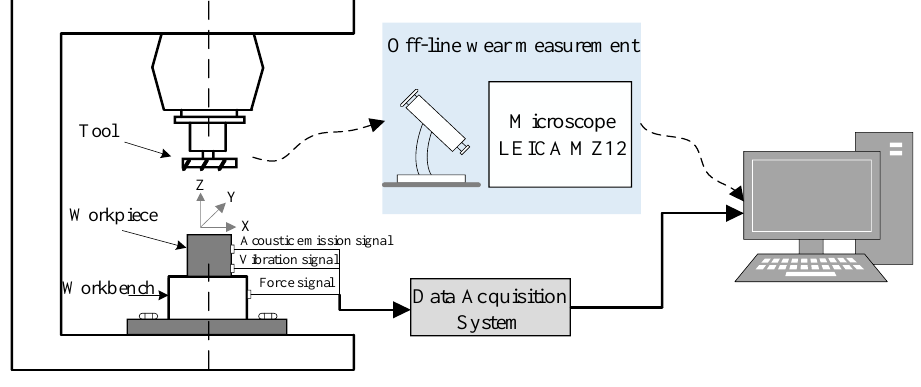
Figure 5. Experimental platform.